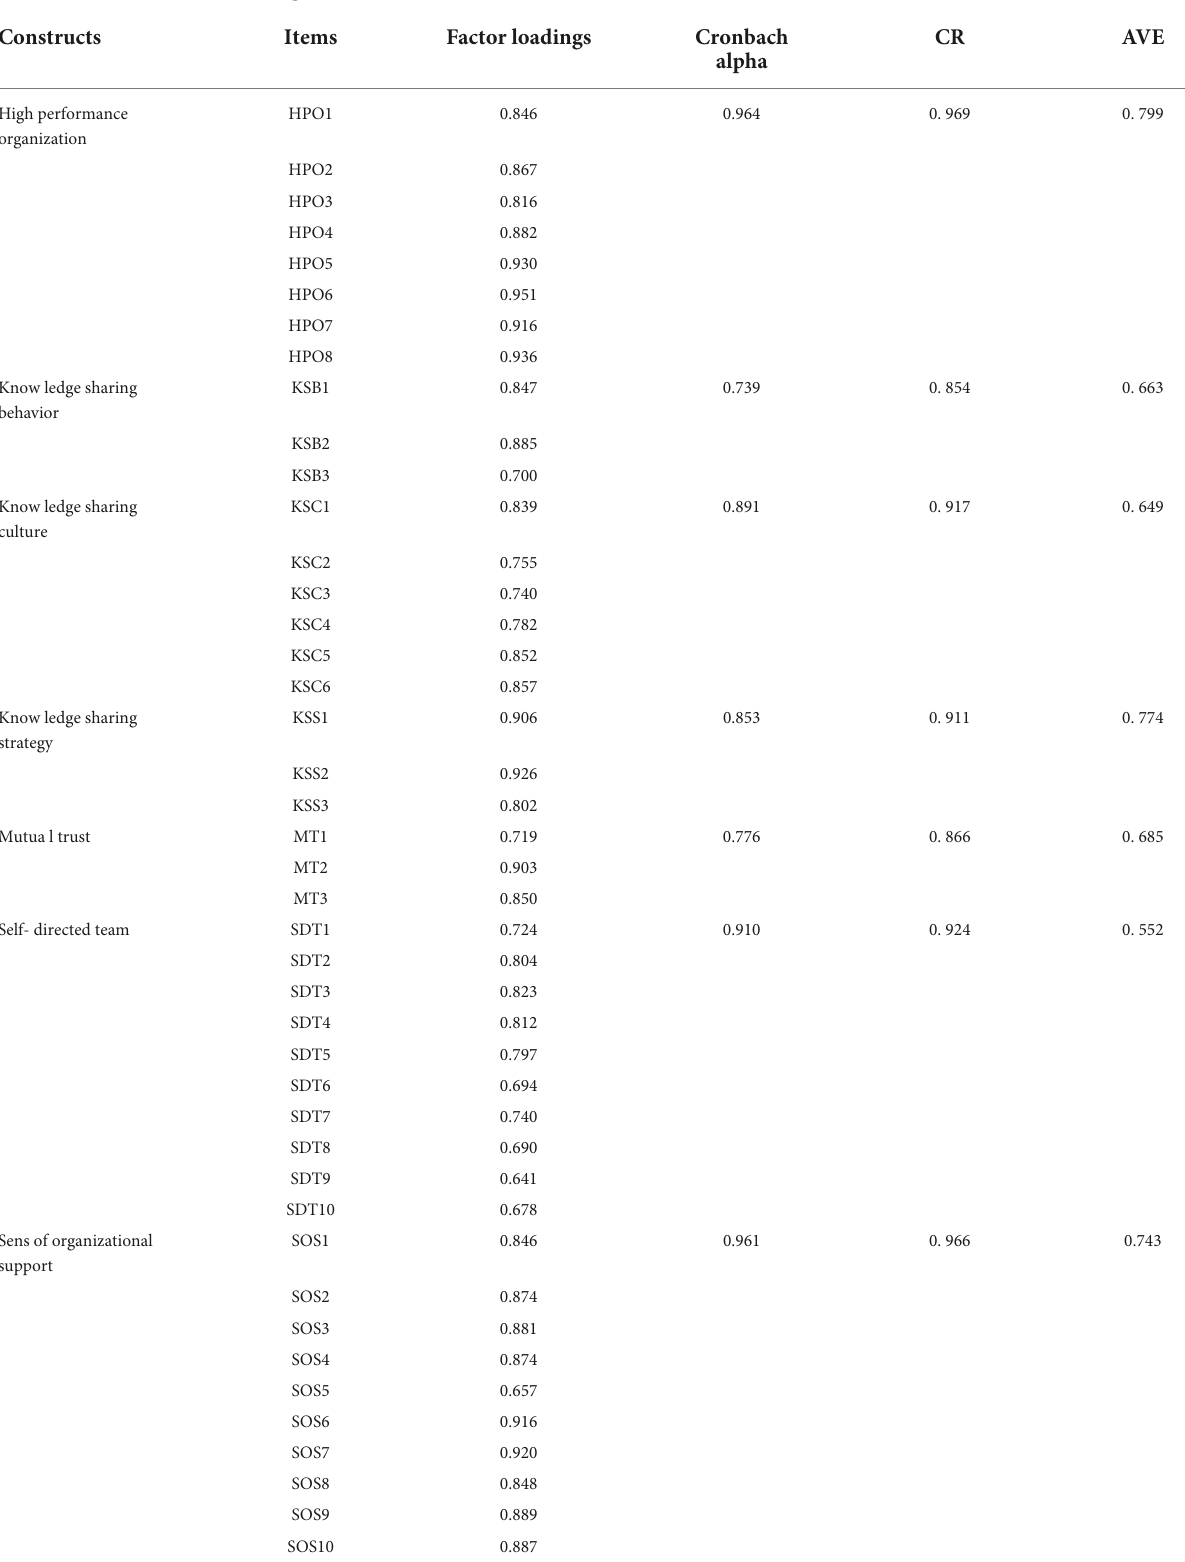
TABLE 2 AVE, CR, and factor